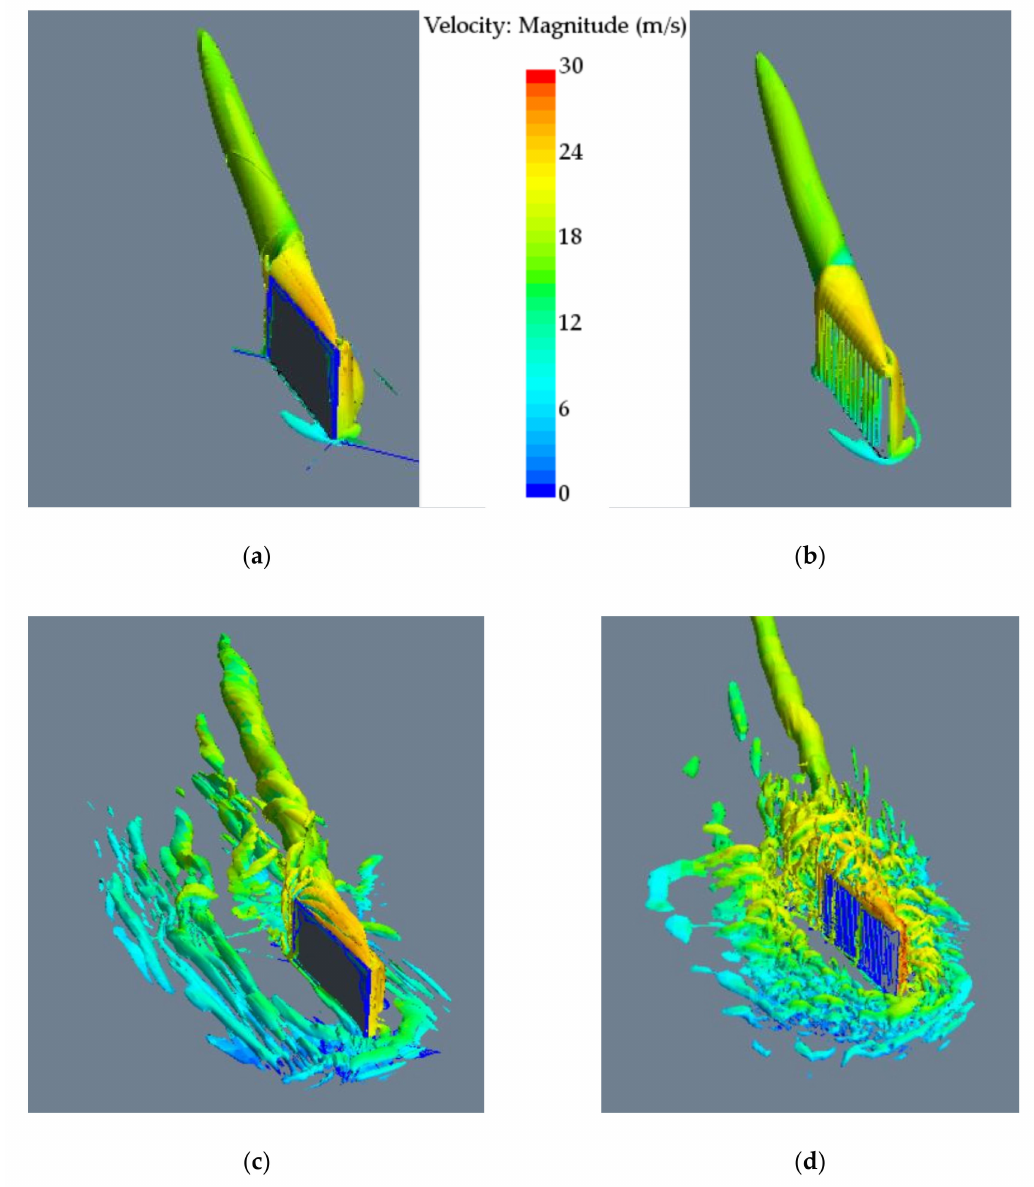
Figure 5. Isosurfaces colored by velocity: ( a ) Reynolds-Averaged Navier-Stokes (RANS) Fully-Resolved Mesh ( α = 18 ◦ ); ( b ) RANS Cell-Set Model ( α = 18 ◦ ); ( c ) LES Fully-Resolved Mesh ( α = 25 ◦ ); ( d ) LES Cell-Set Model ( α = 25 ◦